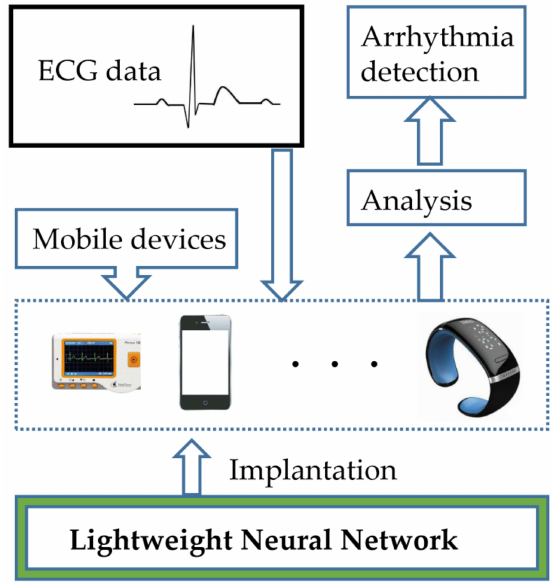
Figure 2. System illustration of arrhythmia detection based on ECG using